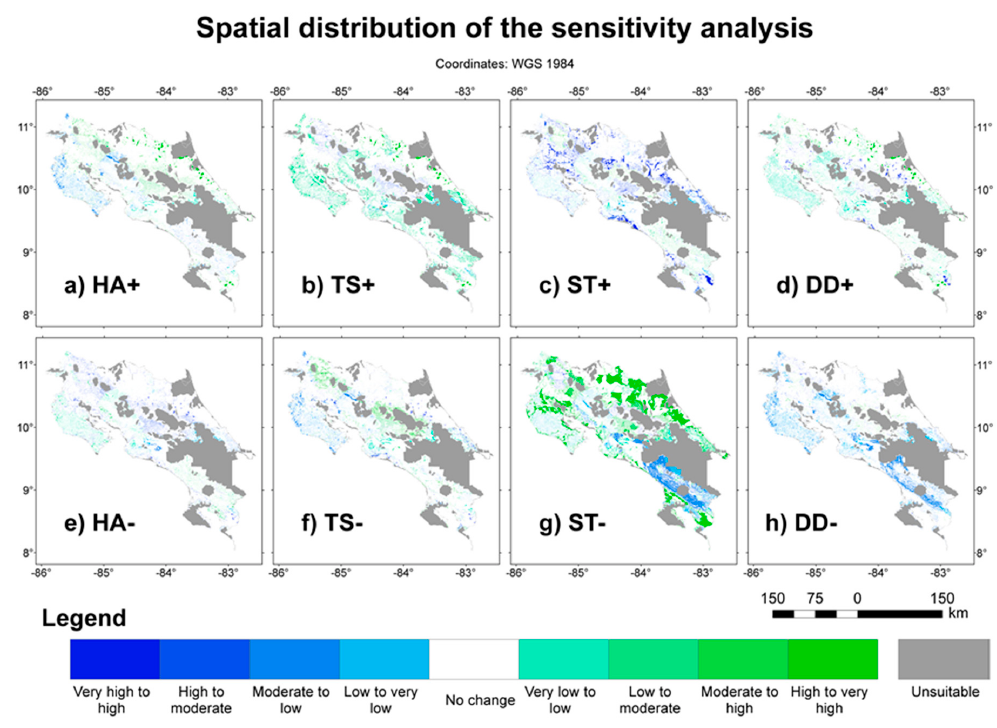
Figure 12. Spatial distribution of the sensitivity analysis scenarios.